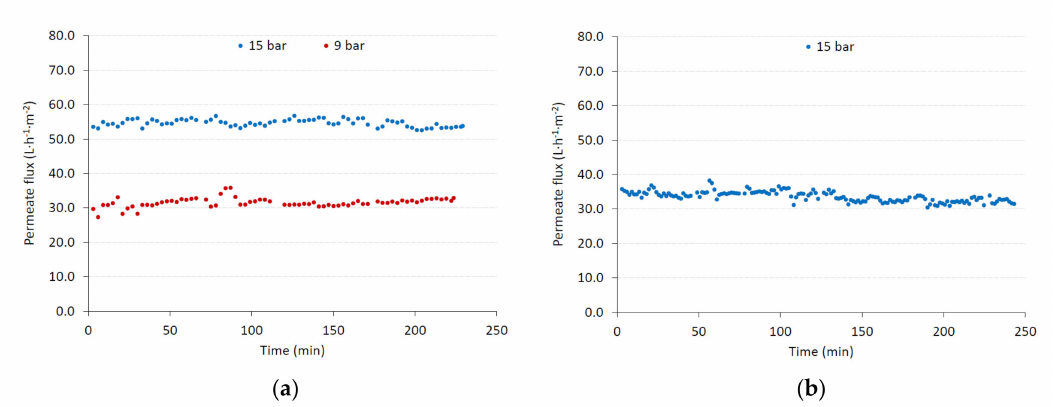
Figure 8. Evolution of permeate flux with time during the nanofiltration step: ( a ) the feed solution was the diluted draw solution from the forward osmosis step, and ( b ) the feed solution was the ultrafiltration